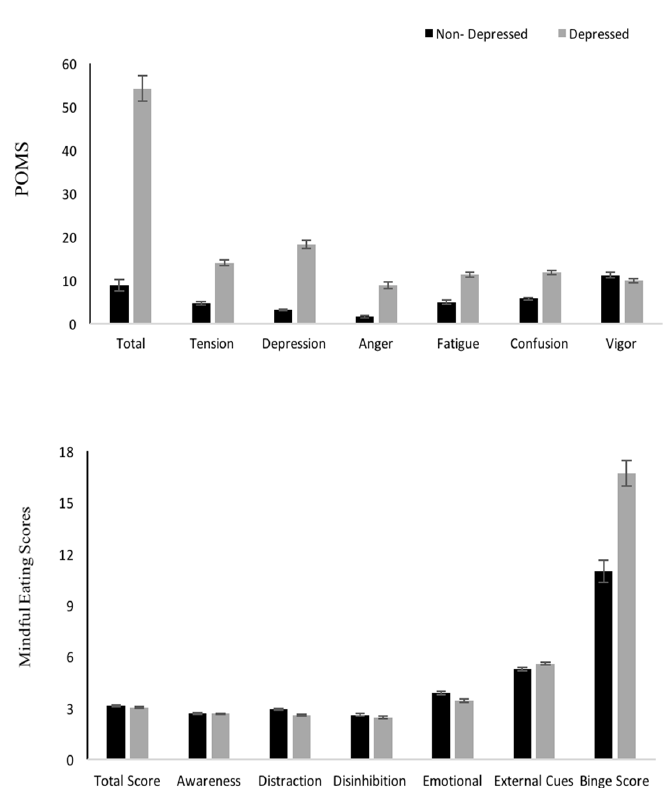
Figure 2. Di ff erences between non-depressed versus depressed students in POMS, mindful total scores and subscales, and total Binge Eating Score (Mean ± SEM). * p <